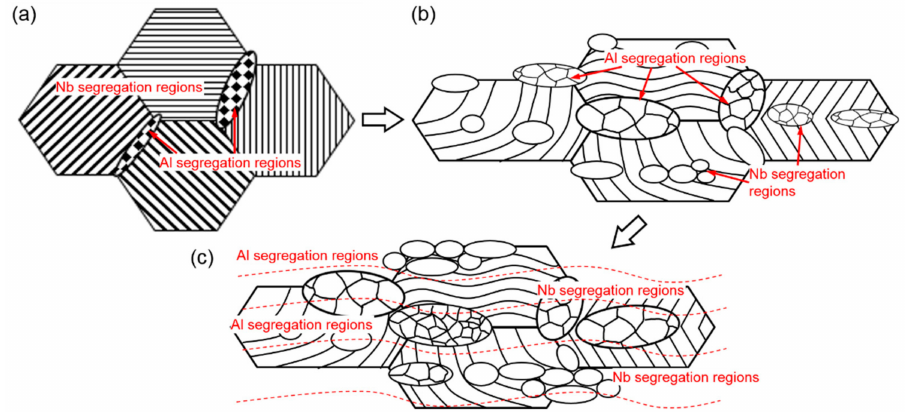
Figure 8. Schematic illustration showing the deformation processes during hot pack rolling for Ti-46Al-8Nb alloys. ( a ) As-cast microstructure, ( b ) the microstructure during the initial deformation period, and ( c ) the microstructure with large strain